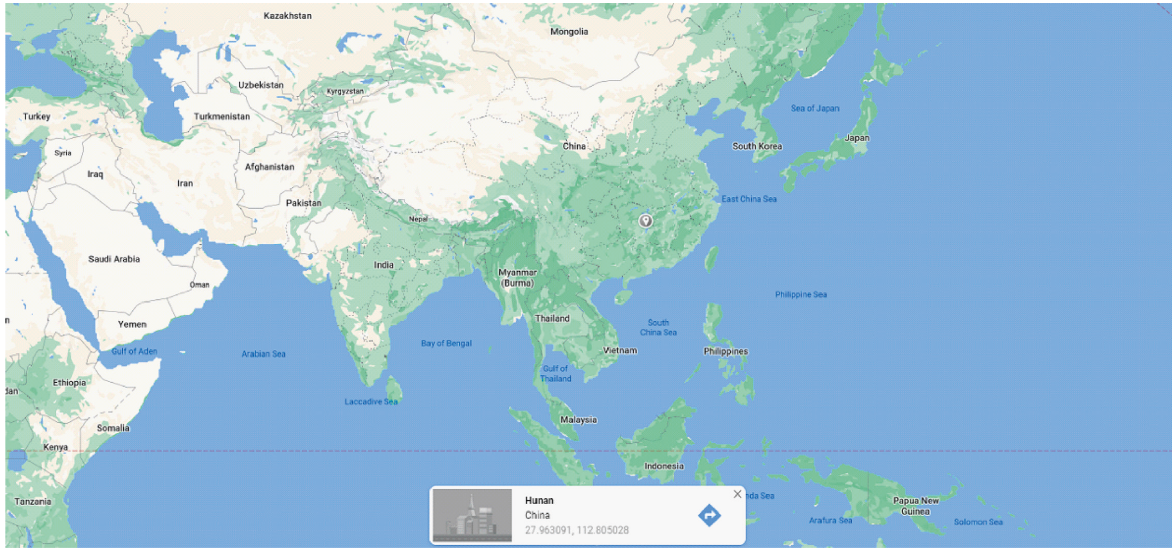
Figure 17: Location of the studied site.